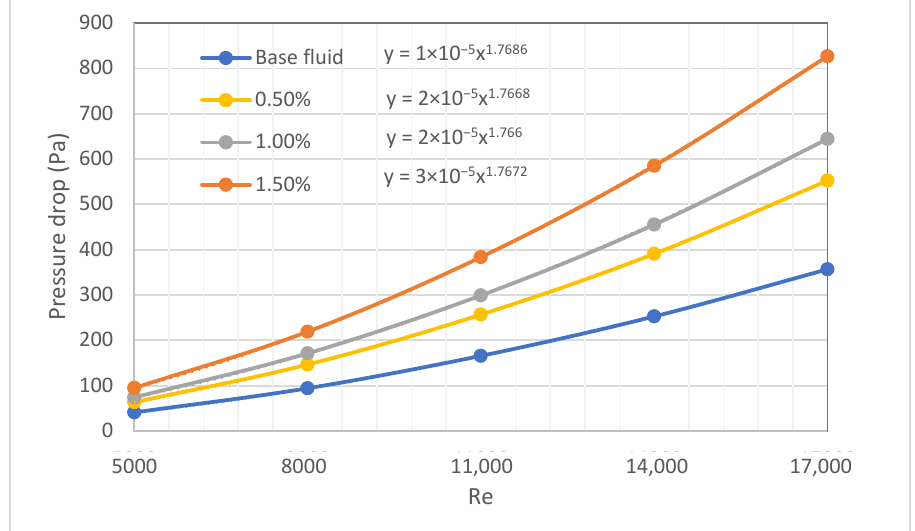
Figure 14. Pressure drops for SiO 2 -P25 hybrid nanofluids by CFD calculation.